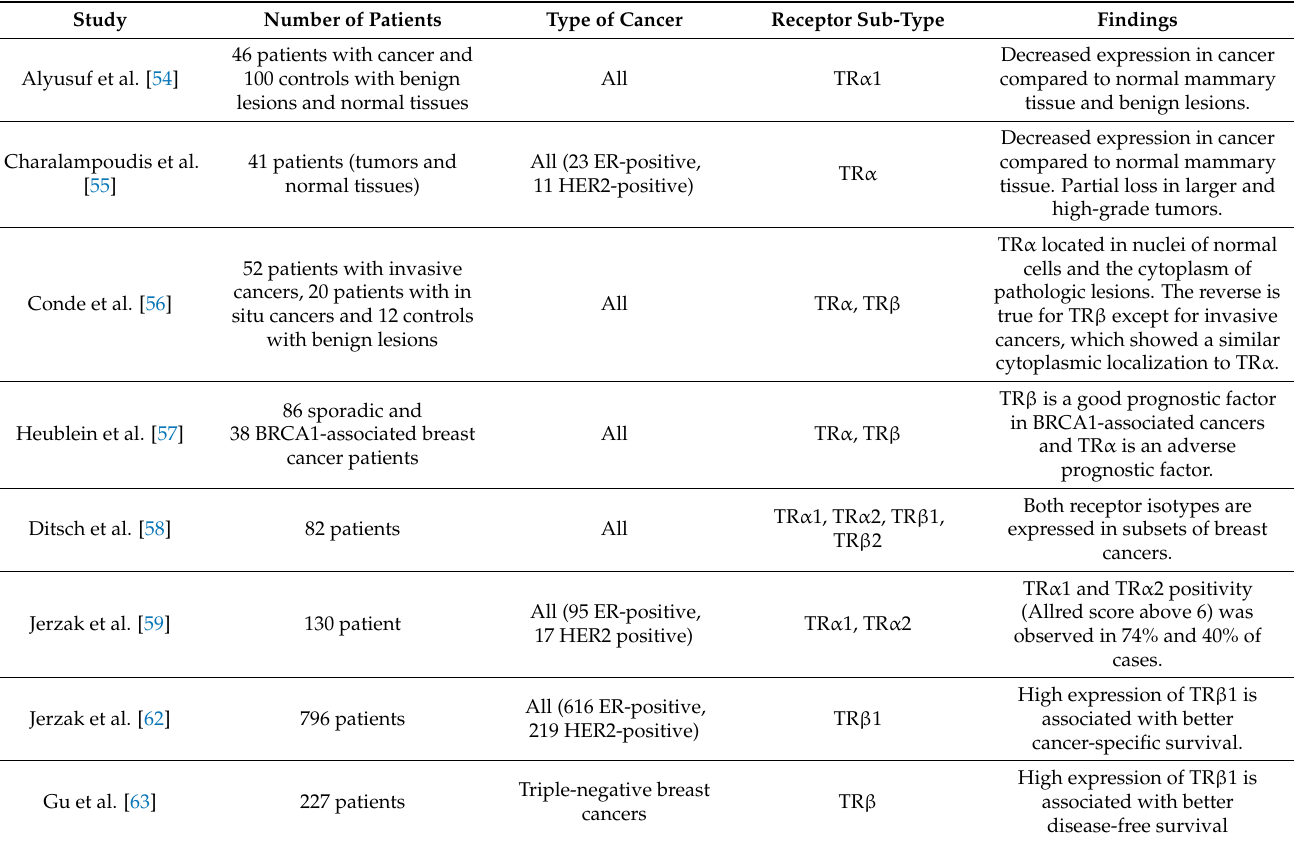
Table 1. Studies of thyroid receptors in breast cancers discussed in this